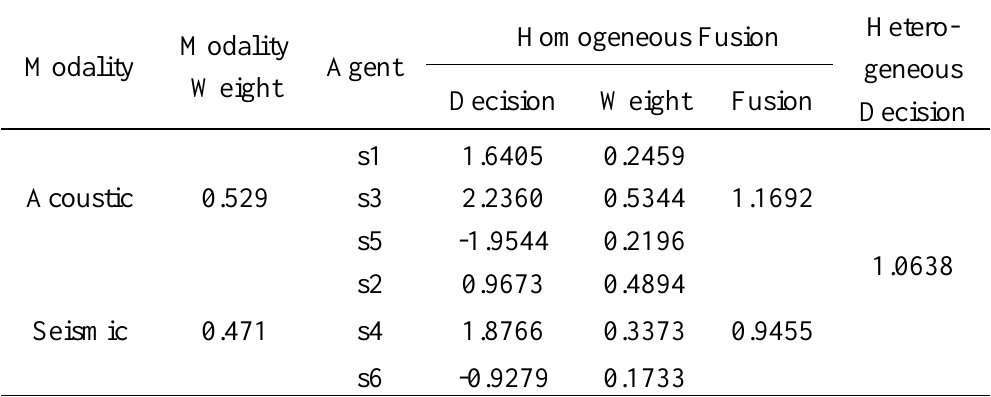
Table 4. Fusion results of agent collaborative classification